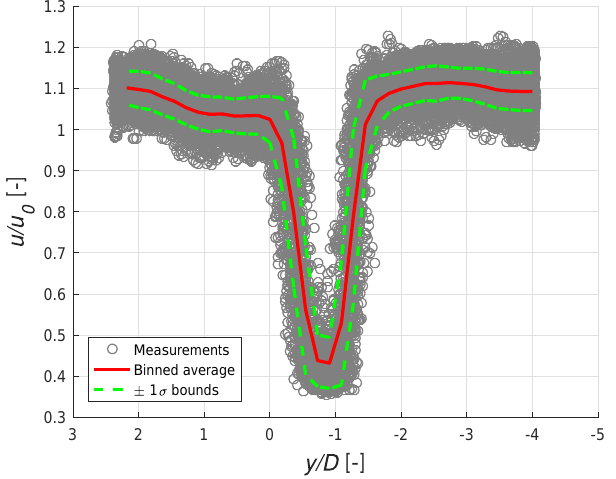
small turbulence scales over a more complex x-shaped vol- ume (see Fig. 6). Figure 21. Wake profile expressed in the evaluated u component at 3 D behind the first turbine with a 20 ◦ yaw angle.